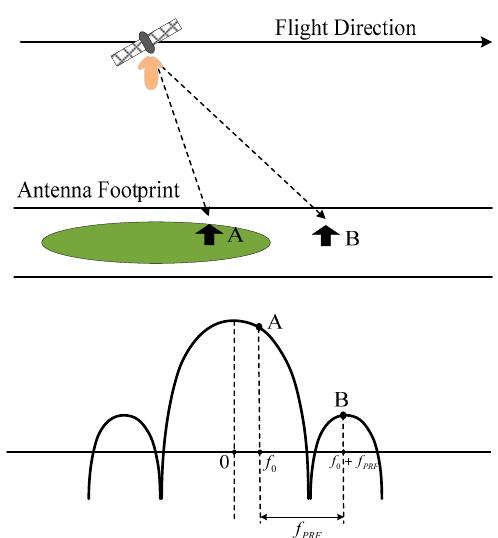
Figure 6. Illustration of azimuth formation in synthetic aperture radar (SAR) images (Points A and B have equal Doppler histories due to aliasing) [50].